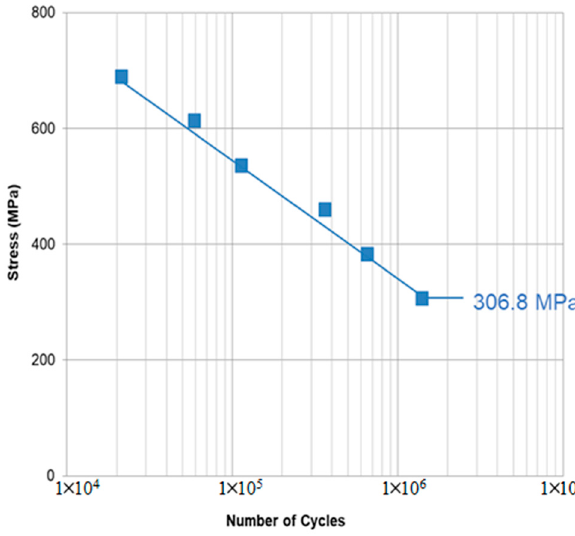
Figure 10. S-N curve for fatigue test result.